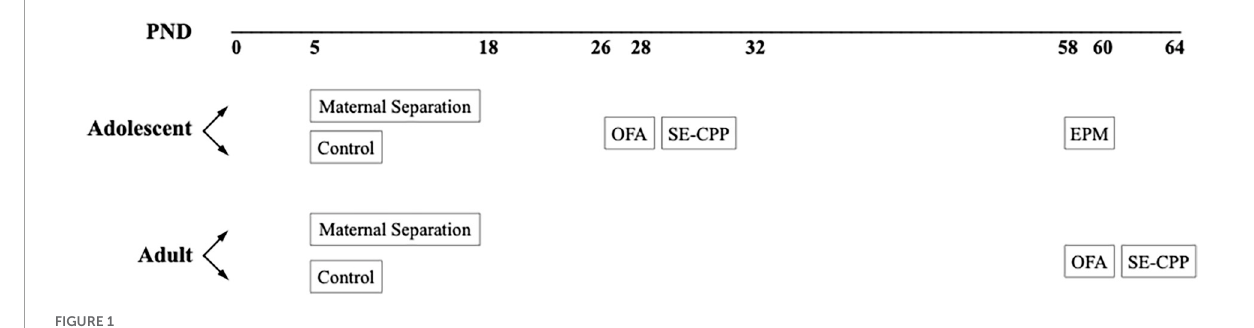
FIGURE1 Schematic of the experimental design.